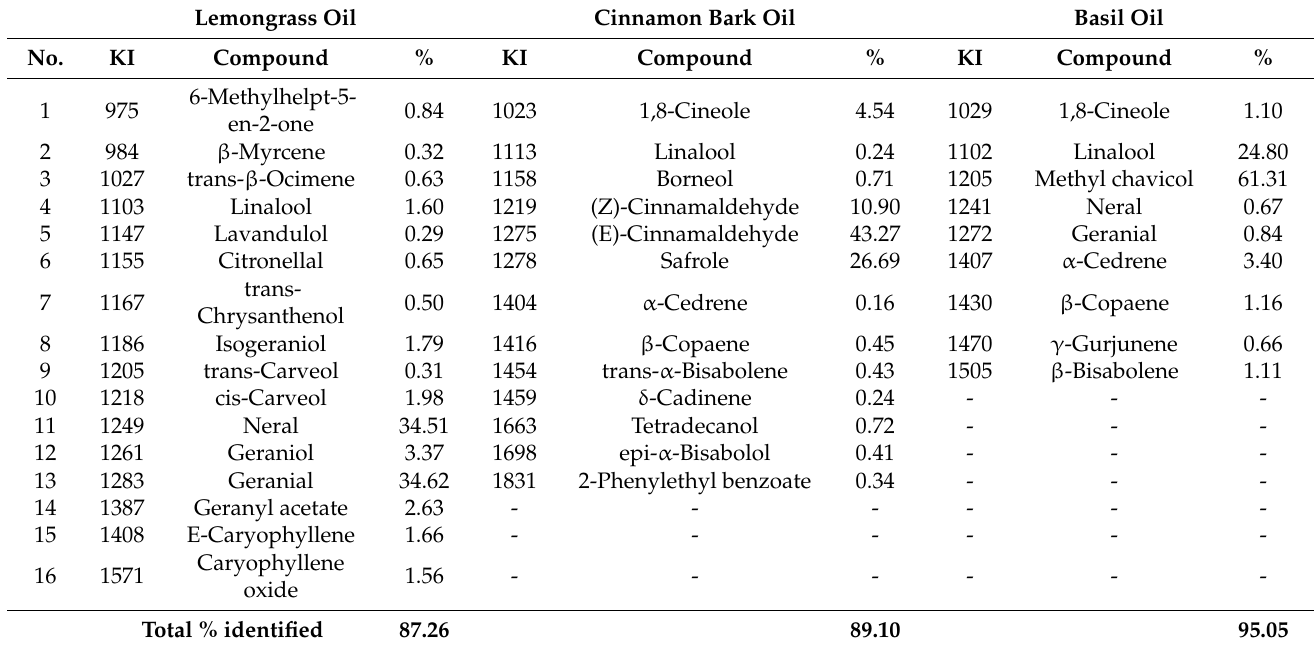
Table 1. Chemical components of lemongrass, cinnamon bark, and basil essential oils